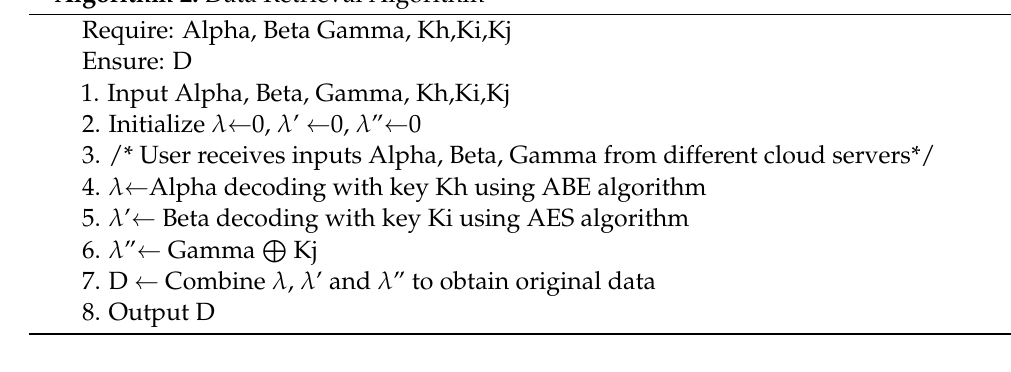
Algorithm 2: Data Retrieval Algorithm